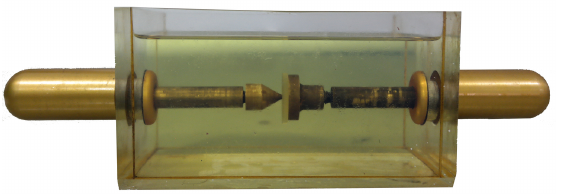
Figure 16. Photograph of the electrodes used for the PD